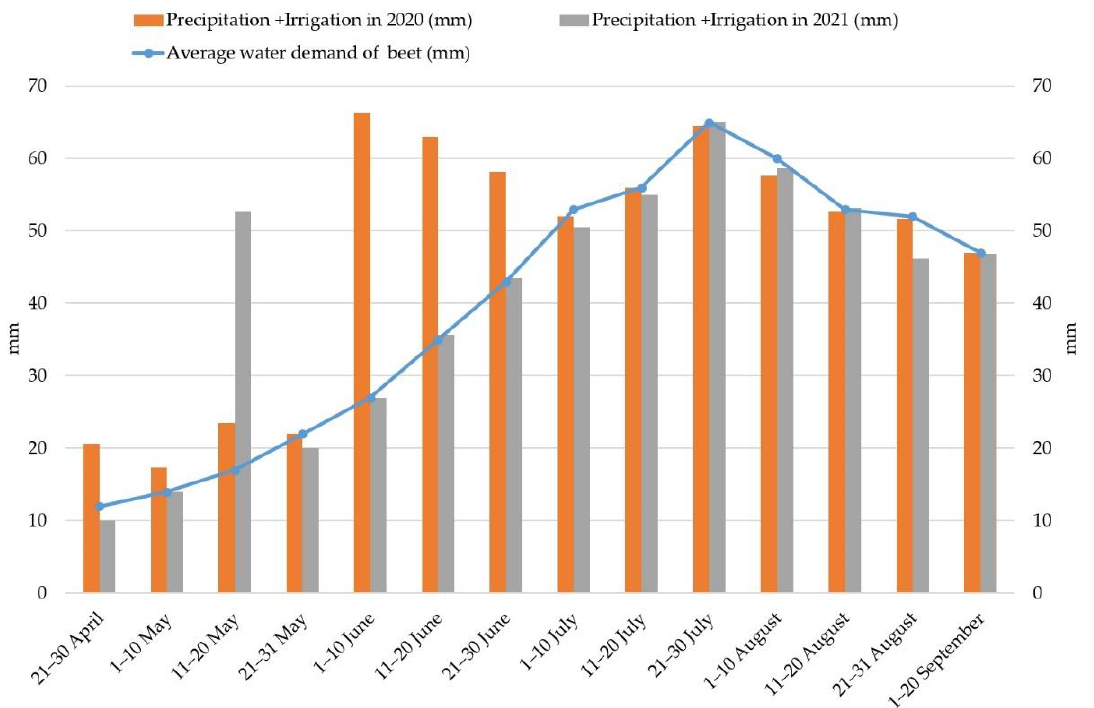
Figure 2. Precipitation plus irrigation water available to beets during two growing seasons. Water demand in “the northern part of the Southern Great Plain region” was described according to Ruzs á nyi in 1990